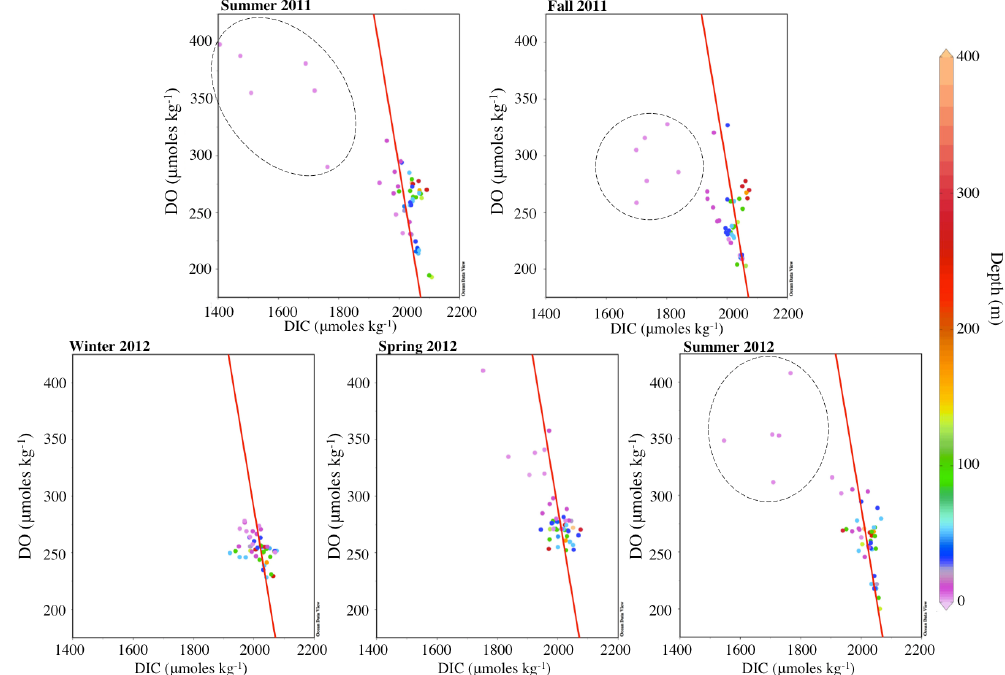
Figure 6. Scatter plots of DIC concentrations vs. oxygen concentrations vs. depth for each season between the summer of 2011 and the summer of 2012. Color bar represents depth in meters. The red line depicts the C:O Redfield ratio of 106 : − 170. Dashed circles highlight samples that deviate from